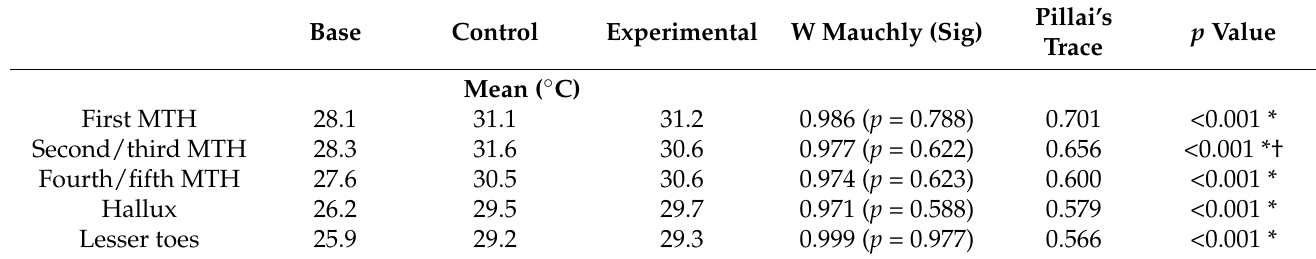
Table 2. Repeated measures